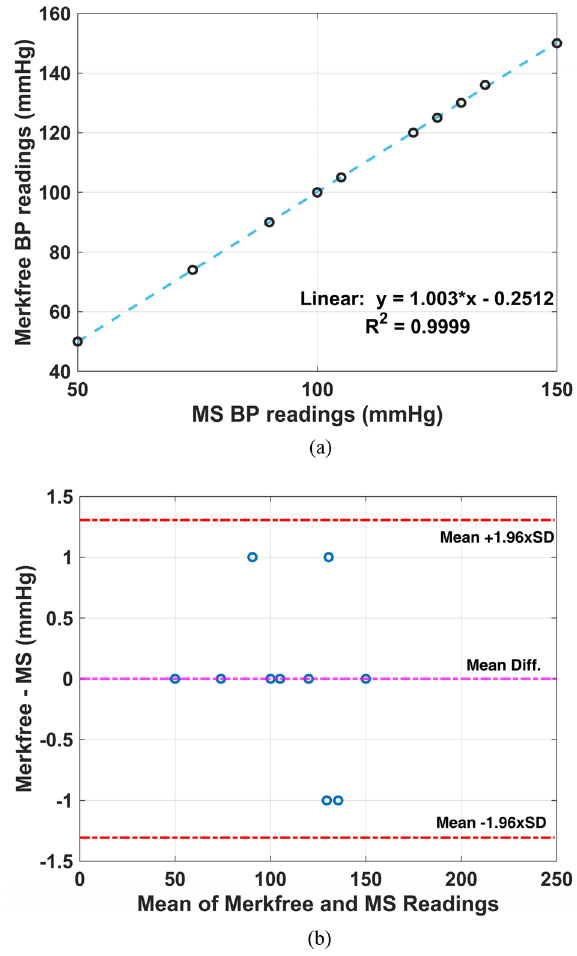
Figure 4. Comparison of pressure readings of Merkfree and Mercury sphygmomanometer. ( a ) The corresponding correlation values, ( b ) Bland Altman’s